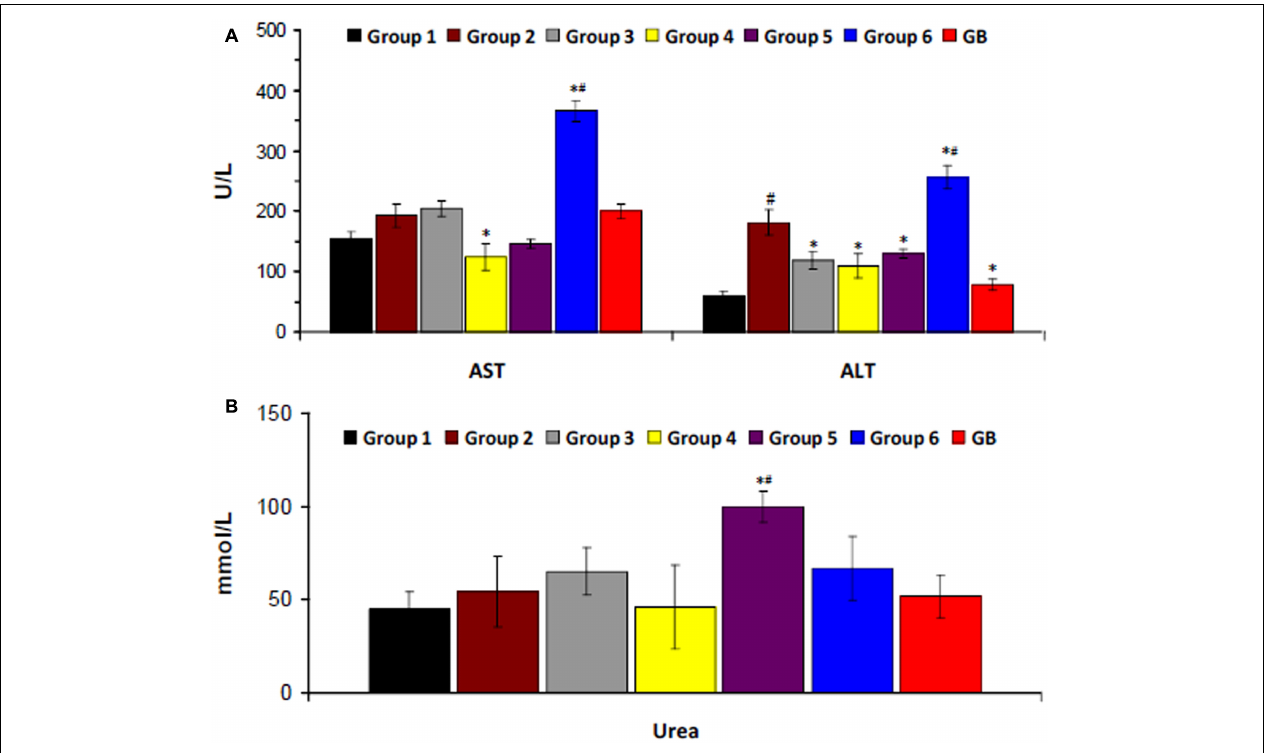
FIGURE 4 | Serum (A) hepatic and (B) renal biomarkers of experimental groups. Data = mean ± SD ; n = 6. ∗ Statistically significant ( p < 0.05) compared to group 2; # statistically significant ( p < 0.05) compared to group 1. Group 1: normal control; Group 2: diabetic control; Group 3: diabetic rats + crude extract; Group 4: diabetic